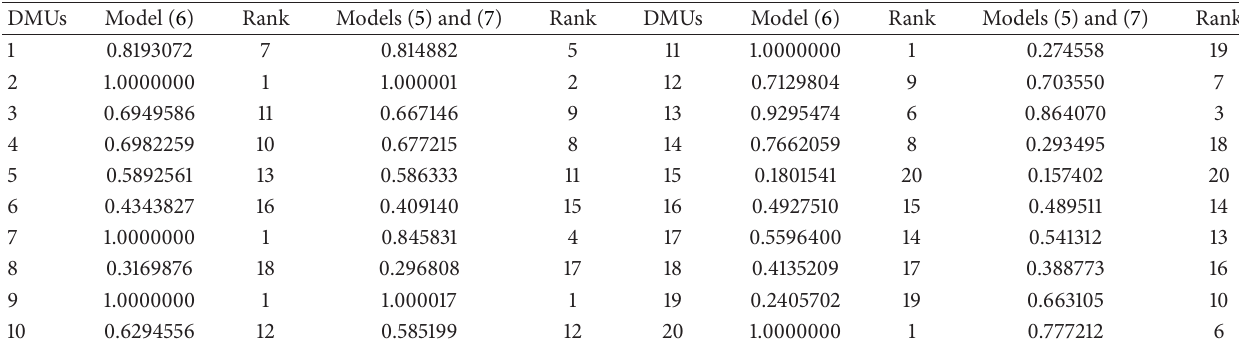
Table 4: The results of 20 bank branches from models (5)–(7).